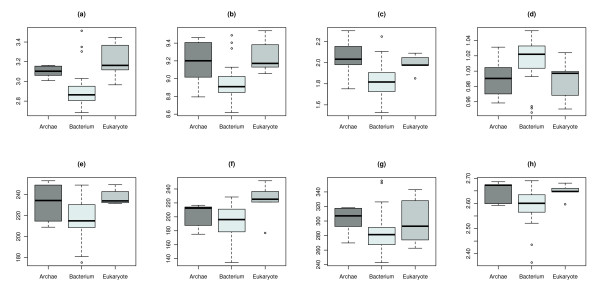
Boxplots for the significant descriptors by ANOVA. This figure shows the boxplots of eight significant topological network descriptors: (a) The Bonchev - Trinajstić index, (b) the Compactness, (c) the Radial centric information index, (d) the Balaban J index, (e) Dehmer entropy using j-spheres, (f) the Dehmer entropy using path lengths, (g) the Dehmer entropy using vertex centrality and (h) the vertex degree equality-based information index, as listed in Table 1.